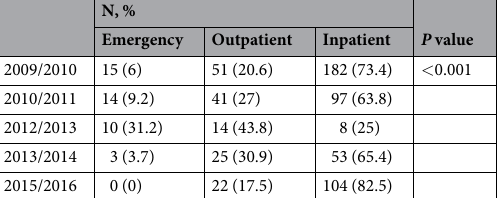
(Fig. S1A). The neuraminidase genes of these viruses were sequencing as well (Fig. S1B). However, no specific amino acid substitutions associated with influenza-related complications was found in each season. Demographic and clinical characteristics of patients with influenza A(H1N1)pdm09 virus clade 6B/6B.1/6B.2 and non-clade 6B/6B.1/6B.2 infection. To compare the effects of the clade 6B/6B.1/6B.2 seasons versus non-clades 6B/6B.1/6B.2 seasons, the patients were classified into two groups. The median (inter- quartile range, IQR) age of patients in the 6B/6B.1/6B.2 season was older than that in the non 6B/6B.1/6B.2 seasons (Table 2). The number of infected individuals aged 50–64 years was higher in 6B/6B.1/6B.2 seasons than that in the non-clade 6B/6B.1/6B.2 seasons (Table 2). The rate of underlying conditions; complications, including pneumonia and acute respiratory distress syndrome (ARDS); ICU admission; respiratory failure with mechan- ical ventilation; 30-day mortality; and in-hospital mortality in 6B/6B.1/6B.2 seasons were significantly higher than that in non-clade 6B/6B.1/6B.2 seasons (Table 2). A higher rate of patients received antiviral treatment after 48 hours in 6B/6B.1/6B.2 seasons (Table 2). Among the female patients, three were pregnant. Demographic and clinical characteristics of patients with complications after influenza A(H1N1)pdm09 virus clade 6B/6B.1/6B.2 and non-clade 6B/6B.1/6B.2 infection. Table 3 showed the baseline characteristics of patients with influenza complications in 6B/6B.1/6B.2 seasons and non-clade 6B/6B.1/6B.2 seasons. The number of infected individuals aged ≥ 50 years was higher in 6B/6B.1/6B.2 seasons than in non-clade 6B/6B.1/6B.2 seasons (Table 3). The rate of underlying conditions; complications, such as ARDS; ICU admission; and respiratory failure with mechanical ventilation in 6B/6B.1/6B.2 seasons was signifi-